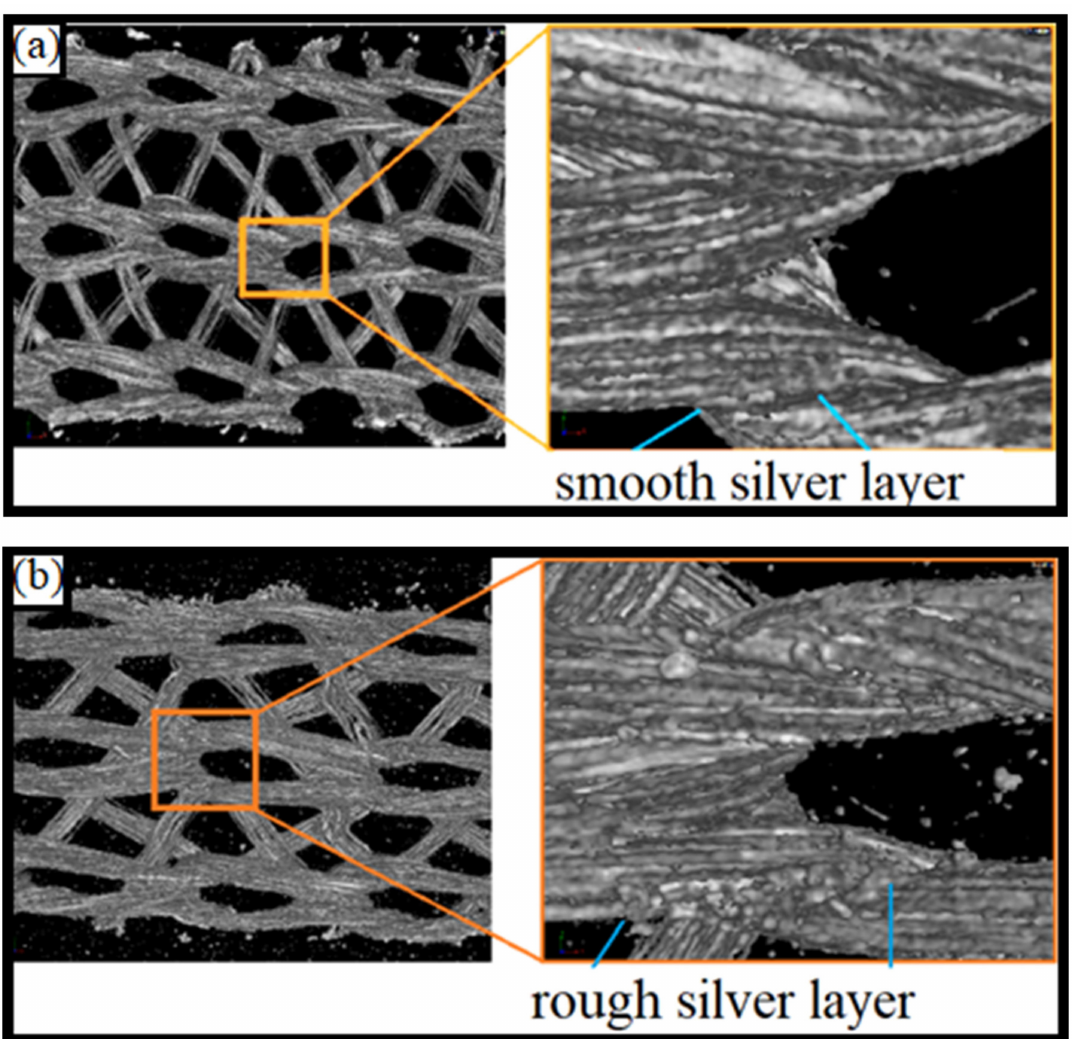
Figure 15. Micro CT as a 3D view of a sample with conductors of knitted textiles: ( a ) untested reference sample; ( b ) tested sample after 300,000 cycles at a strain amplitude of